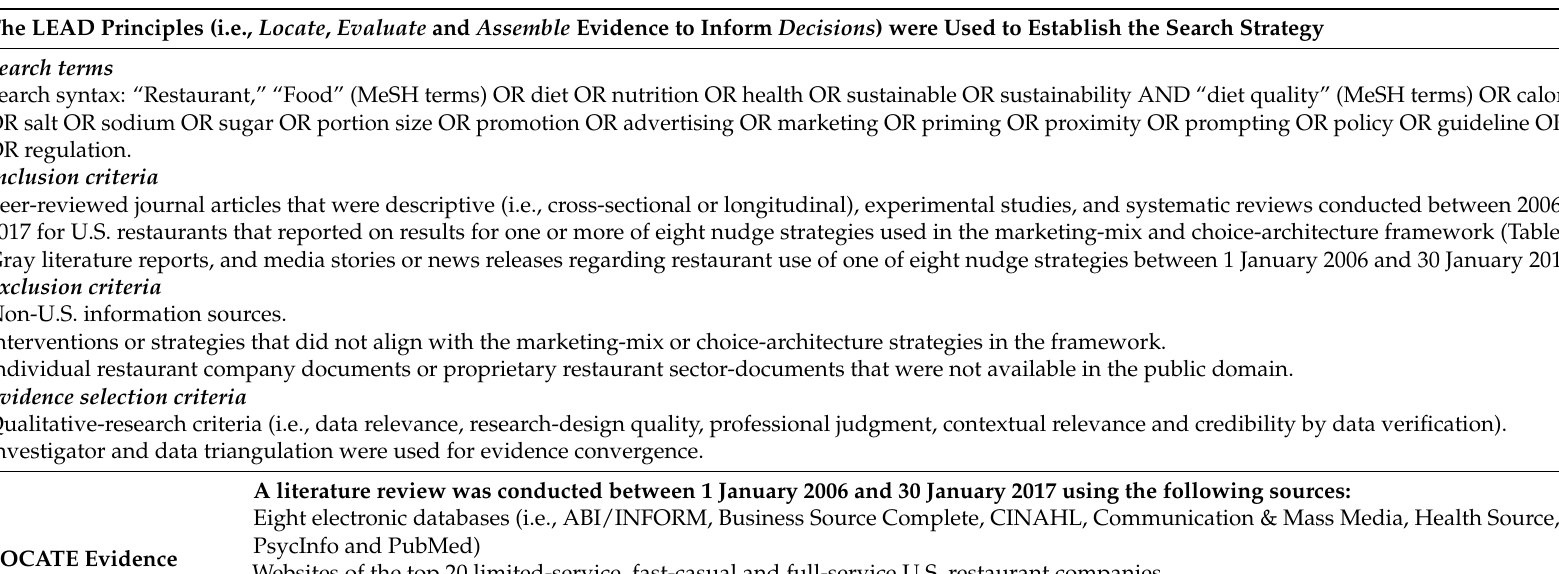
Table 2. Approach for acquiring and organizing the evidence to evaluate U.S. restaurant-sector progress, December 2006–January